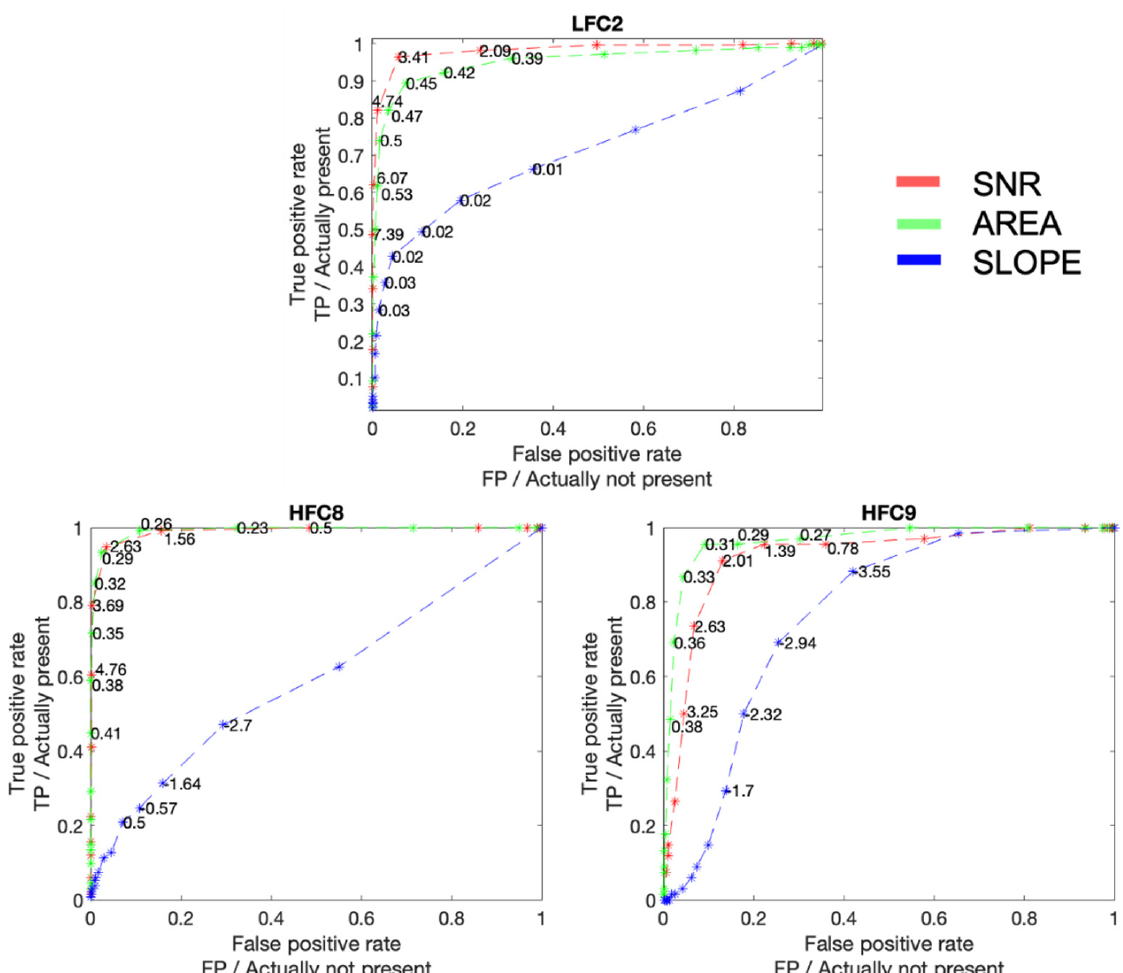
Figure 5. Receiver operating characteristics (ROC) curves for the three detection methods, SNR, PSD area, and PSD slope estimating the presence of the three fin whale choruses, LFC2, HFC8, and HFC9. Different threshold values for the respective thresholds, TSNR, TARE, and TSLO are given next to the respective markers in the plots.